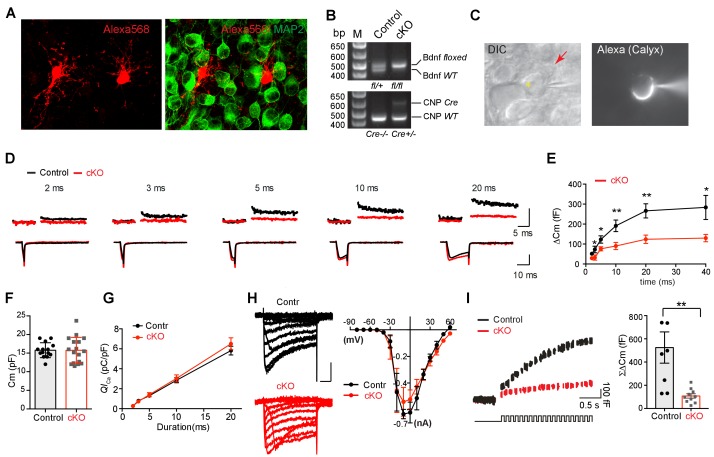
Removal of endogenous BDNF from oligodendrocytes affects exocytosis of vesicular glutamate at the presynaptic terminal.(A) Confocal images of oligodendrocytes filled with Alexa 568 using whole-cell recording and MNTB principal neurons, which were immunolabeled with MAP2, from a WT mouse (P10). (B) Conditional deletion of BDNF in oligodendrocytes (Cnpcre: Bdnffl/fl). Genotyping PCR using genomic DNA from control and Bdnf cKO mice, which are Cnpcre: Bdnffl/+ and Cnpcre: Bdnffl/fl, respectively. (C) DIC and fluorescence images of the patched calyx terminal filled with Alexa568. Oligodendrocyte (red arrow) was located in close to the calyx synapse in the MNTB. Yellow asterisk indicates MNTB principal neuron. (D) Representative traces for membrane capacitance (Cm; top) and Ca2+ current (ICa; bottom) induced by 2-, 3-, 5-, 10-, and 20 ms depolarization (bottom) from P10–12 calyx terminals in control (black) and Bdnf cKO (red) mice. Scale: 200 fF (top) and 500 pA (bottom), respectively (E) Depolarization duration plotted against ΔCm for control (black; 2 ms, n = 23; 3 ms, n = 16; 5 ms, n = 23; 10 ms, n = 27; 20 ms, n = 24; 40 ms, n = 3) and Bdnf cKO mice (red; 2 ms, n = 25; 3 ms, n = 10; 5 ms, n = 24; 10 ms, n = 25; 20 ms, n = 23; 40 ms, n = 4). (F) Summary of the resting Cm in WT and Bdnf cKO mice. (G) The plot of depolarization duration versus Ca2+ current charge (QICa) was generated from data as in (D) for both genotypes. (H) Left: Representative traces of ICa induced by a 100 ms step-like depolarization (from –80 to 60 mV, Δ10 mV) in control (black; n = 4) and Bdnf cKO mice (red; n = 5). Right: The I–V relationship for voltage-activated Ca2+ channels at the calyx terminal for each genotype is also shown. (I) Summary of the ΣΔCm after the train of 20 depolarizing pulses (at 2 s) for each genotype. Data are shown as the mean ± s.e.m. *p<0.05; **p<0.01 (unpaired t-test).